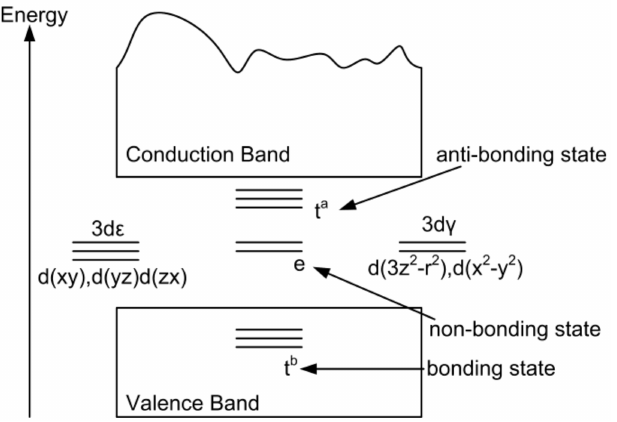
Figure 5. Energy graph of 3 d transition-metal atoms in a tetrahedral crystal field ( T d